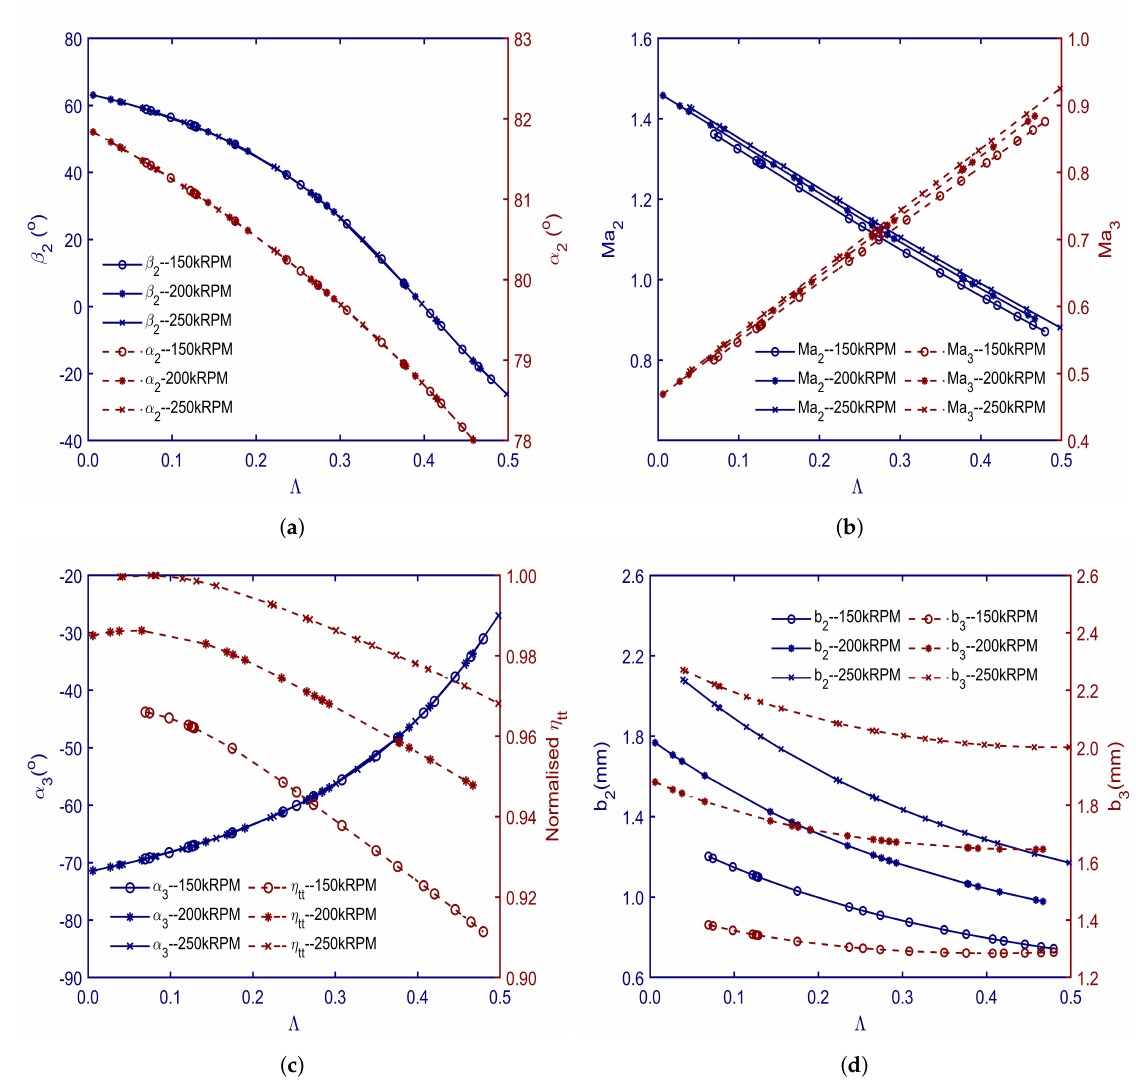
Figure 6. Degree of reaction versus ( Λ ) ( a ) flow angles [ β 2 and α 2 ] ( b ) Mach number at the rotor inlet [Ma 2 ] and exit [Ma 3 ] ( c ) normalised efficiency [ η tt ] and swirl angle [ α 3 ] ( d ) blade heights [b 2 and b 3 ] at various rotational